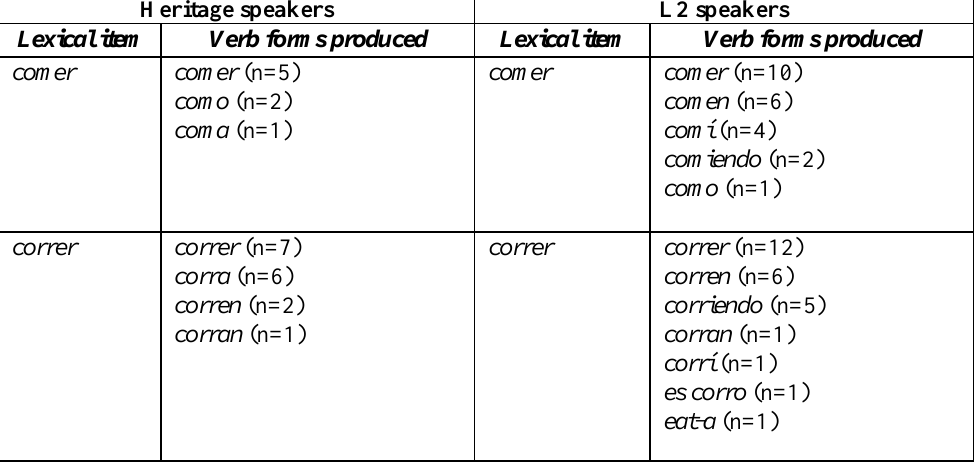
Table 5. Children’s non-target-like productions by verb and group